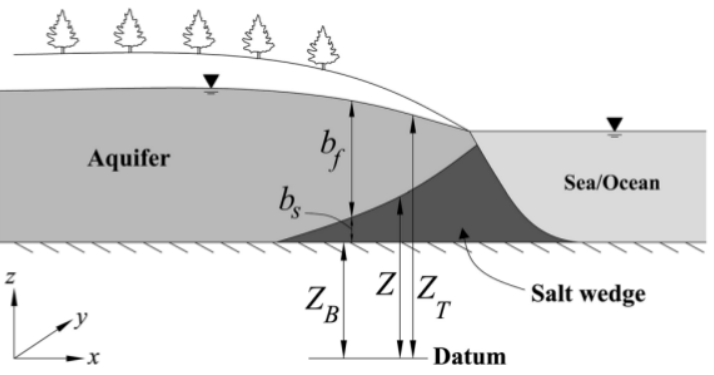
Figure 1. Interface and other related elevation from [16].